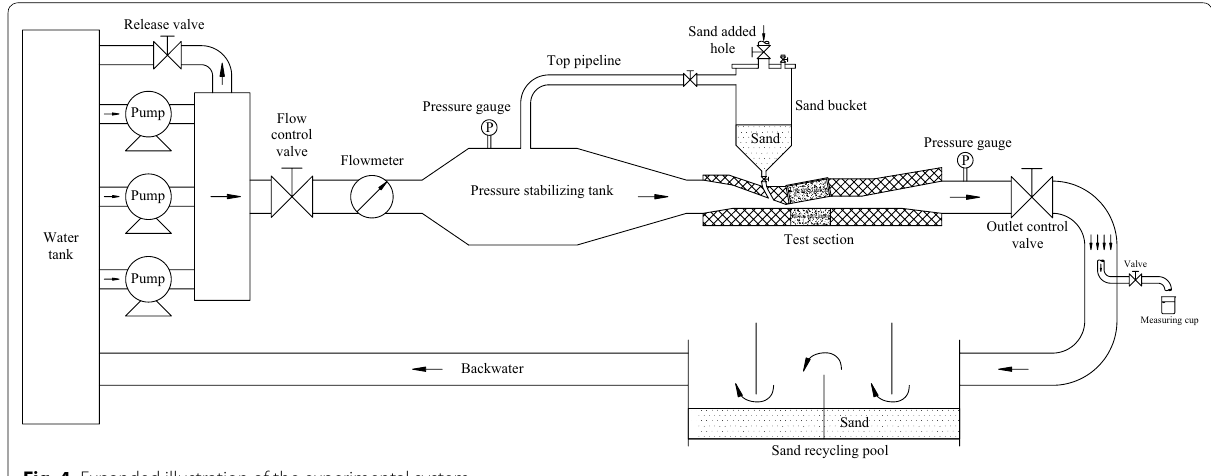
Fig. 4 Expanded illustration of the experimental